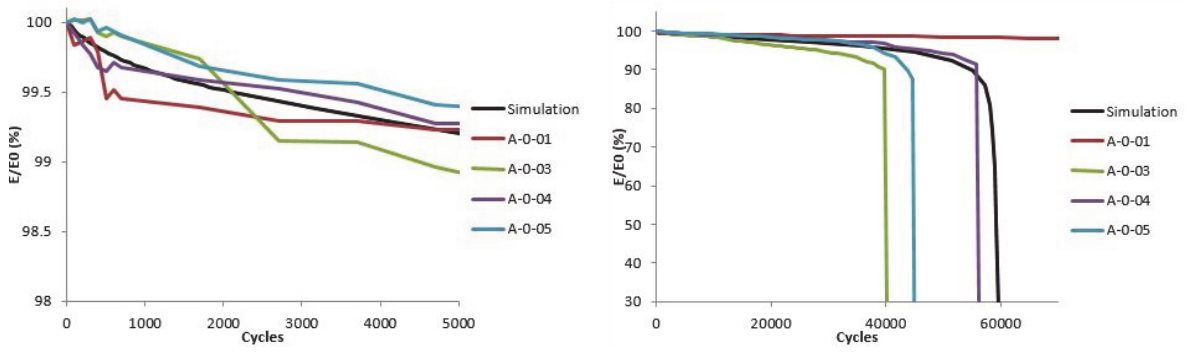
Figure 5: Correlation between experimental and simulated stiffness evolutions ([0]20 layup in 3 point bending).